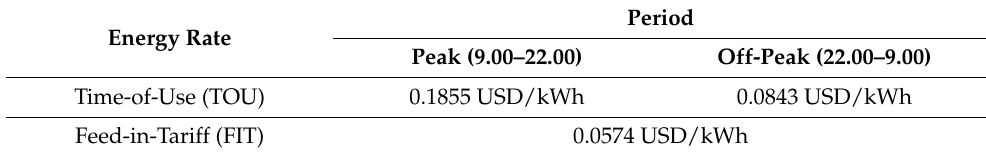
Table 1. The hourly TOU and FIT rates [5].